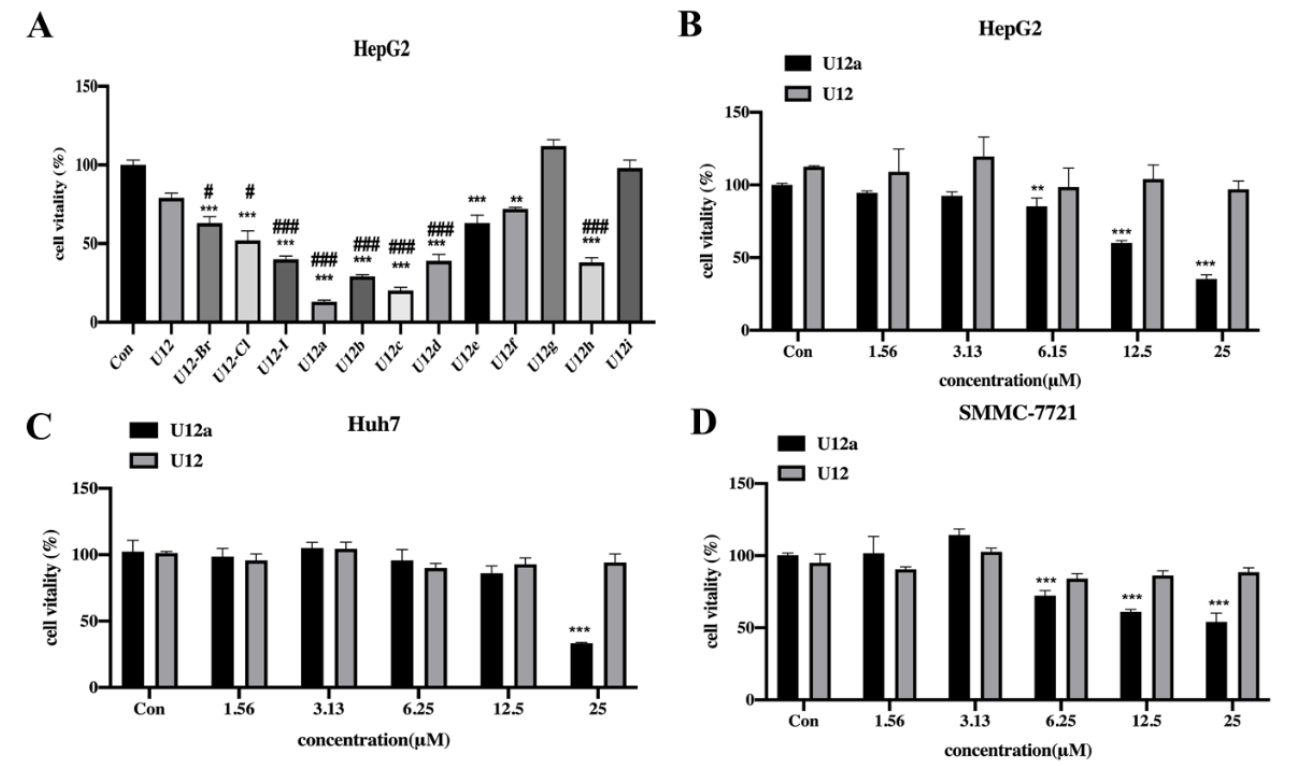
Figure 2. Cytotoxic effects of the U12 derivatives on HepG2 cells. ( A ) Cell viability of HepG2 cells after 24 h exposure with U12 derivatives (25 μM) by MTT assay. ( B – D ) Effects of U12a and U12 on viability of HepG2, Huh7, SMMC-7721 cells by MTT assay. (HepG2 cells were treated with different concentrations of U12a or U12 for 24 h, stained with MTT, and the OD value was measured at a wavelength of 490 nm.) All data represent the mean ± SD of three independent experiments. ** p < 0.01, *** p < 0.001 vs. control group, # p < 0.05, ### p < 0.001 vs. U12 group.